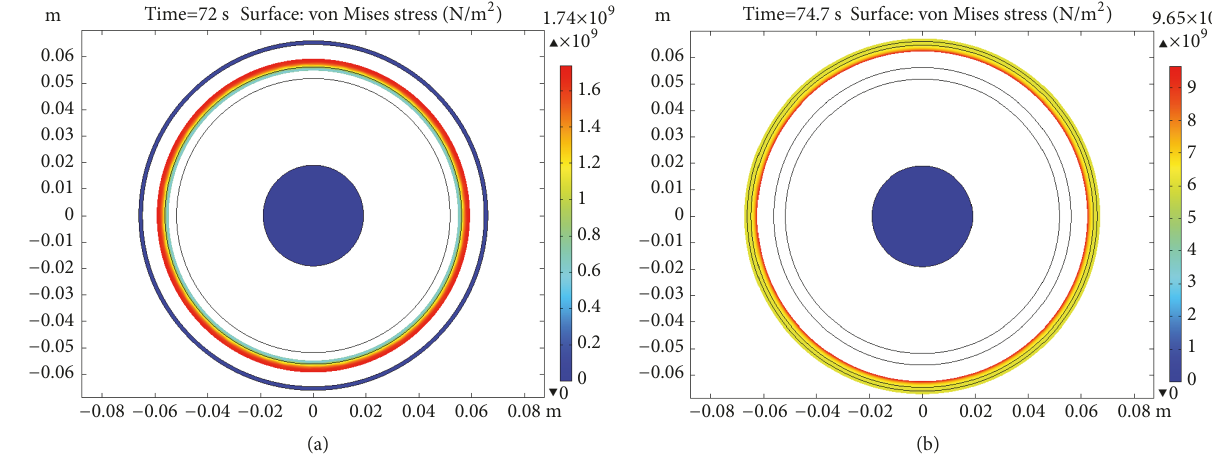
Figure 4: Von Mises stress: (a) 72 s, before contact, and (b) 74.7 s, after contact.